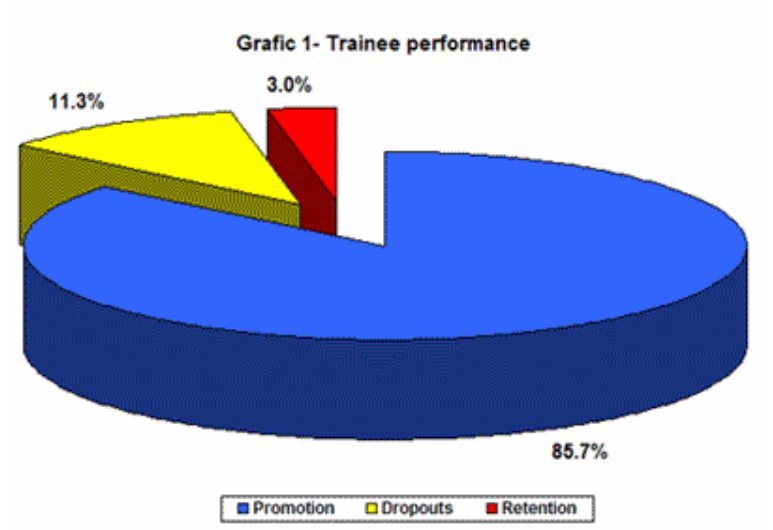
Figure 2a . Teacher-Trainee Performance